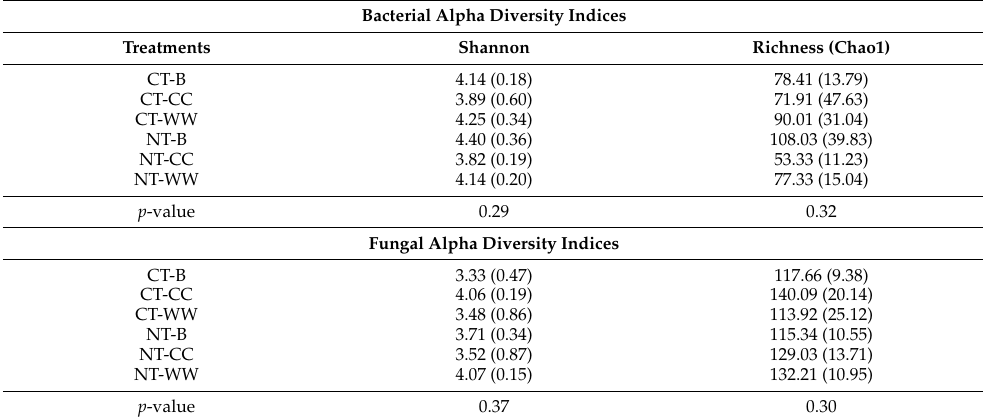
Table 1. Soil bacterial and fungal alpha diversity indices under combination of crop rotation, tillage practice and winter cover management